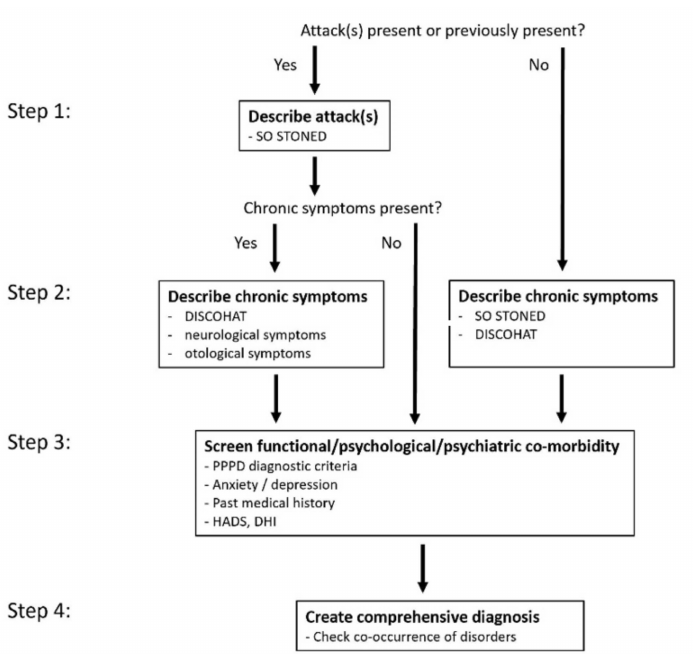
Figure 1. The 4-step approach to history taking in patients with non-acute vestibular